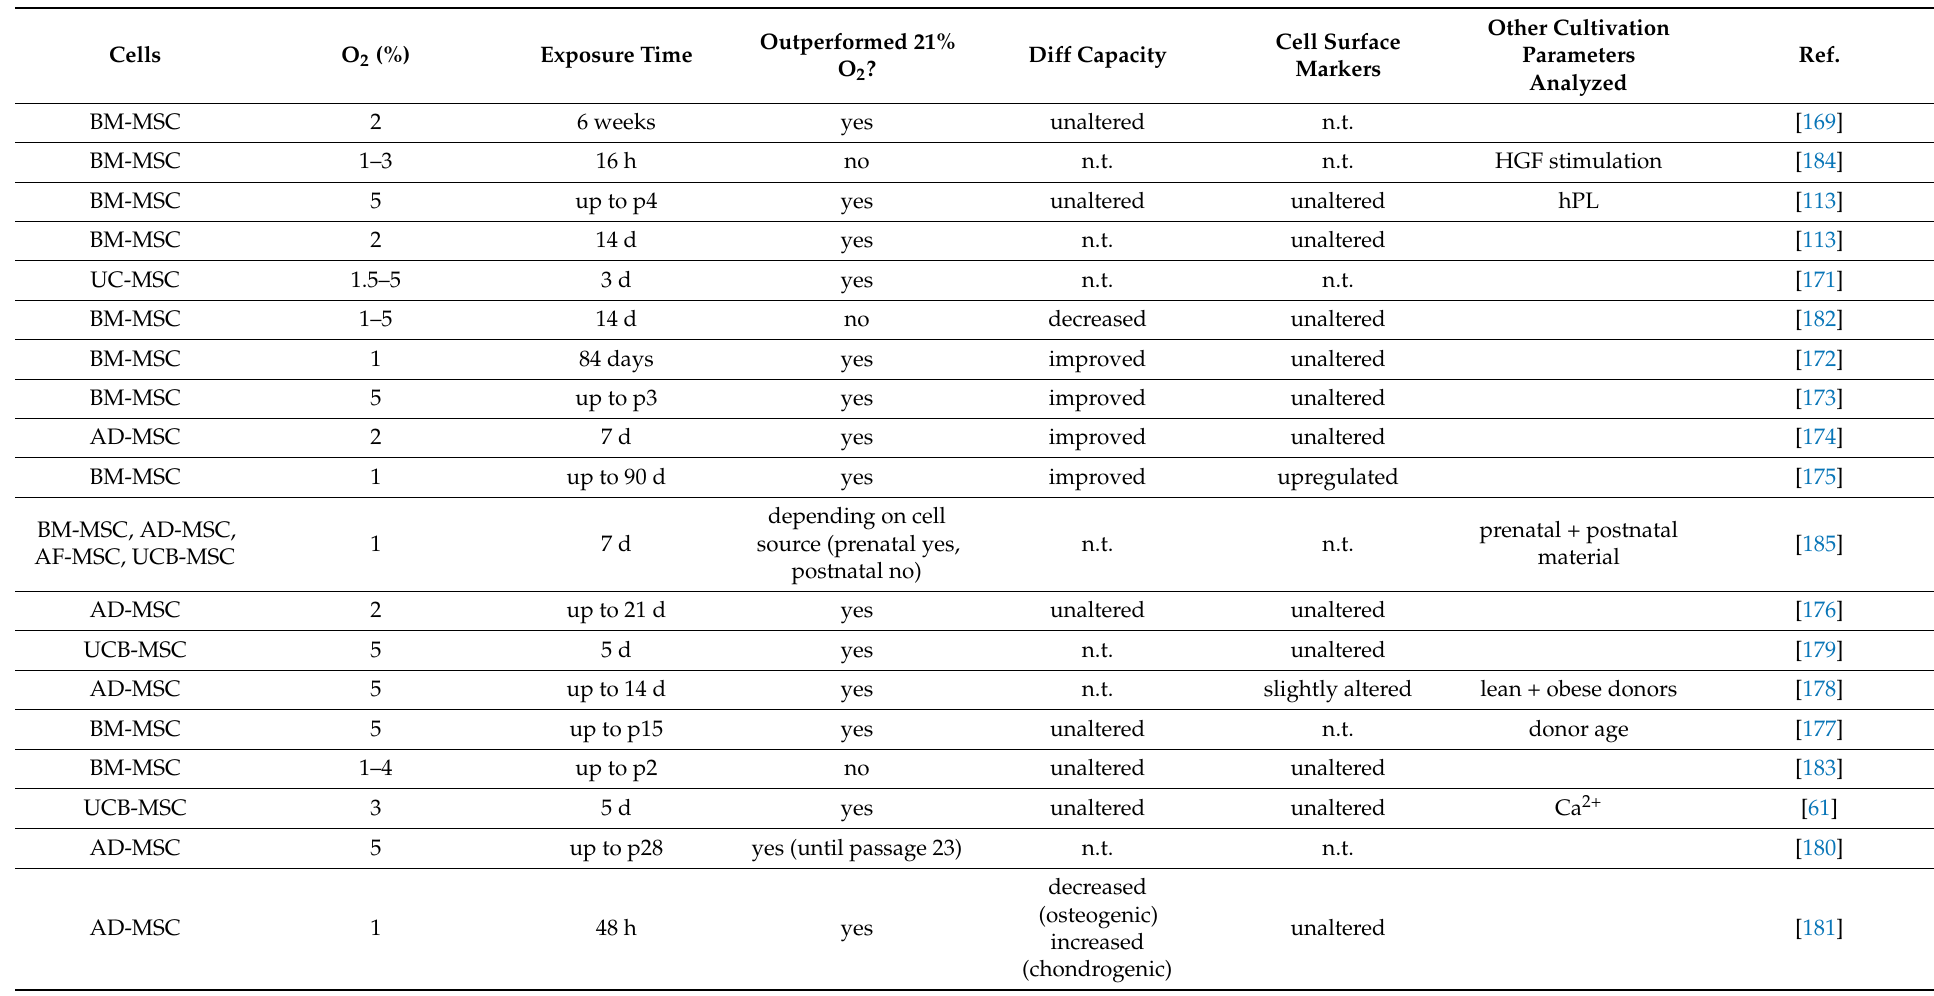
Table 5. Hypoxic conditions for expansion of hMSC; selected studies from 2007–2020. Information is given on the cell source, exposure to hypoxic conditions and on stem cell characteristics.